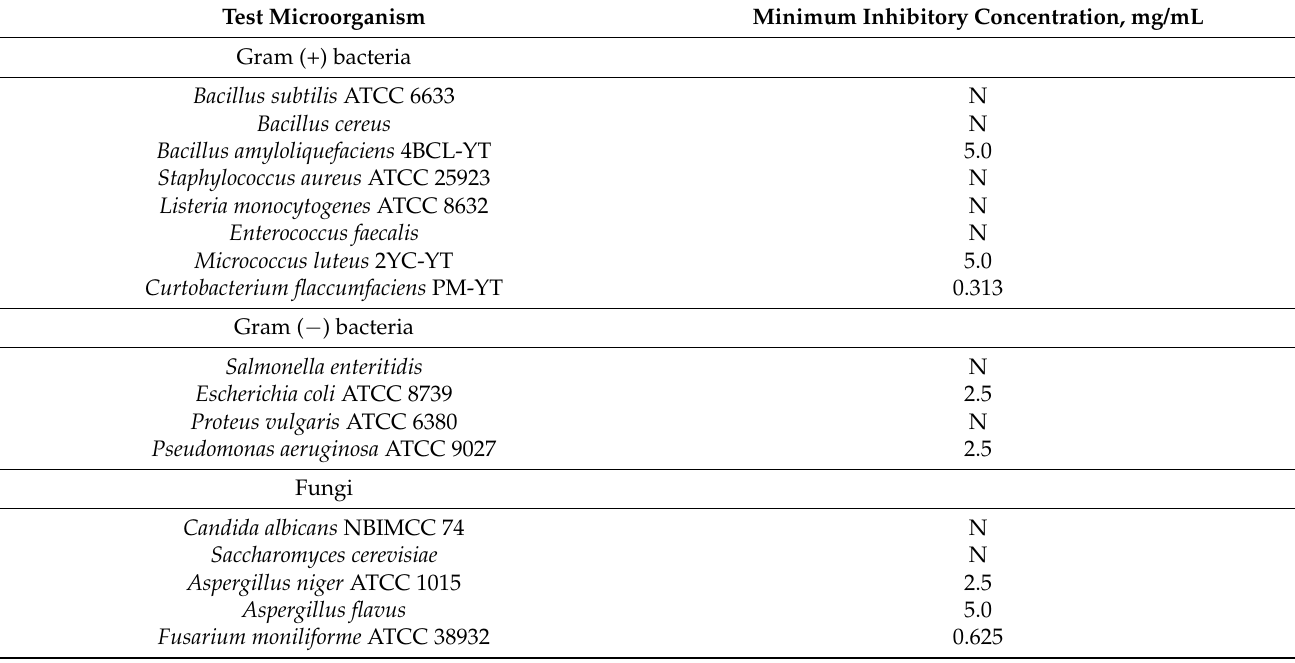
Table 5. Minimum inhibitory concentration (MIC) of sunflower meal ethanol-wash solute against the test microorganisms. Test